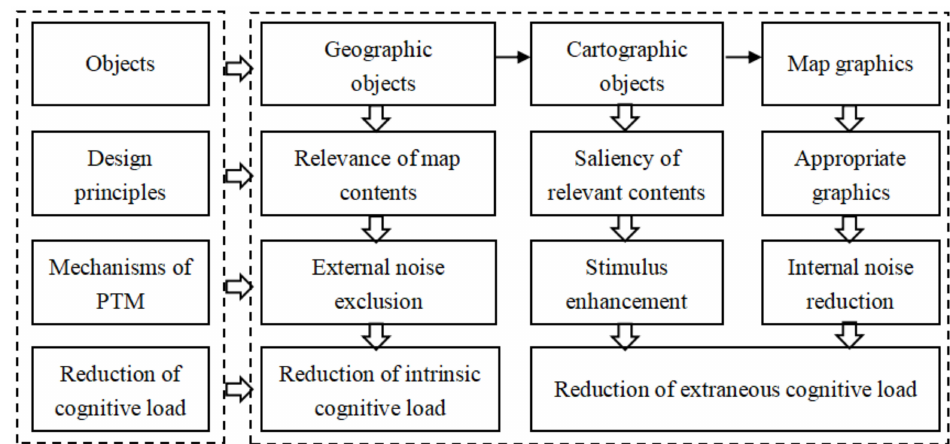
Figure 3. Design principles of crisis maps based on